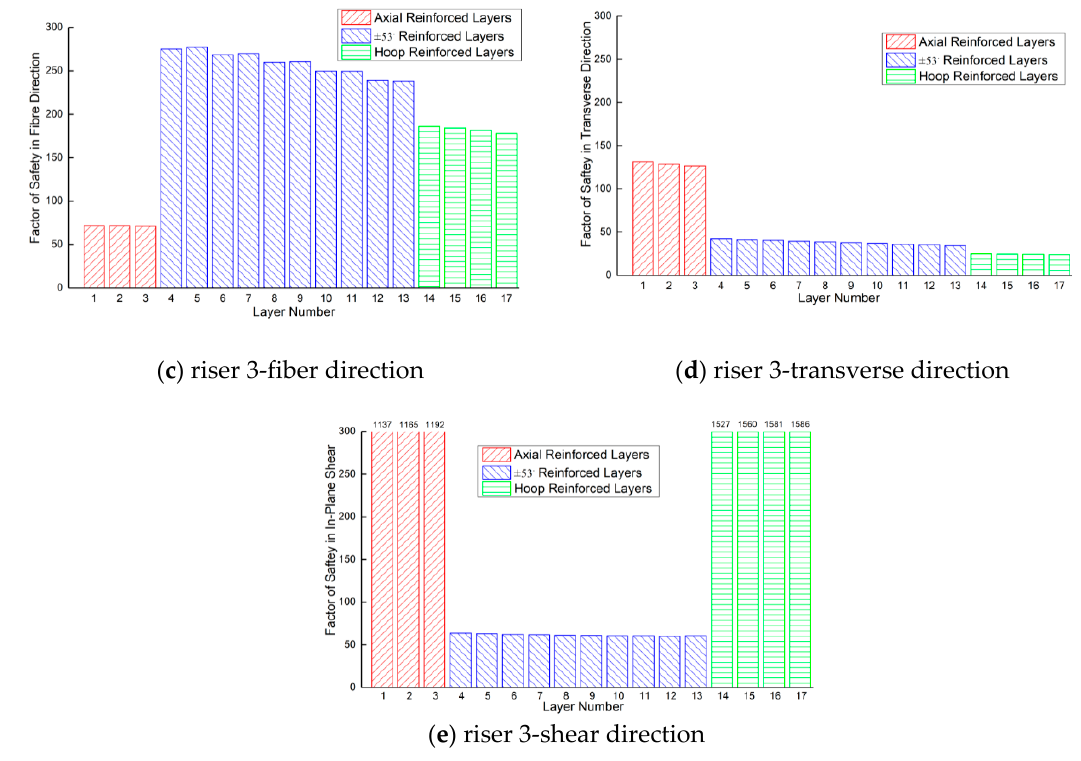
Figure 14. Factor of safety of composite layers for 1.22 m/s in ( a ) riser 2 ‐ fiber direction, ( b ) riser 2 ‐ transverse direction, ( c ) riser 3 ‐ fiber direction, ( d ) riser 3 ‐ transverse direction and ( e ) riser 3 ‐ shear direction.